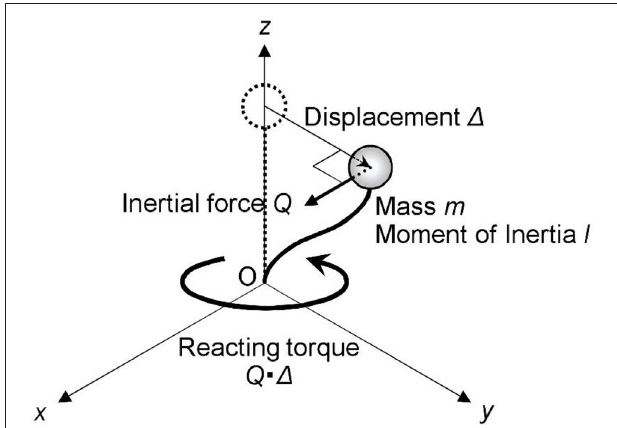
FIGURE 1 | Torque induced by lateral displacement and perpendicular inertial